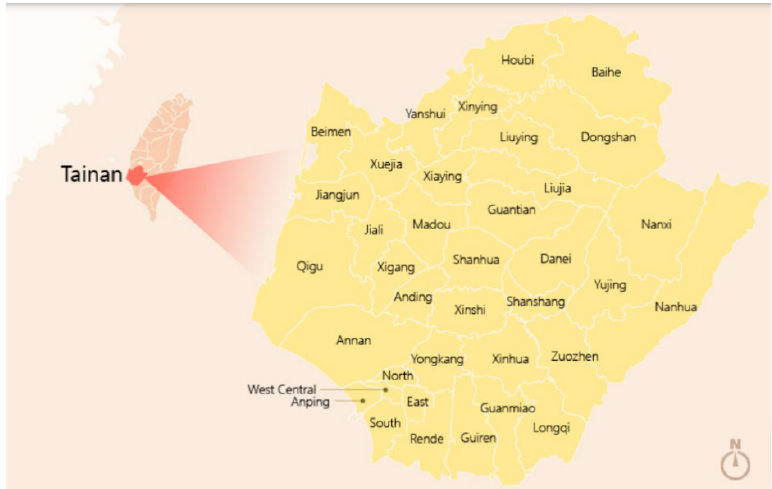
Figure 1. Location of survey site in Tainan. Data source: Tourism Bureau of Tainan City Government Figure1. LocationofsurveysiteinTainan. Datasource: [49].